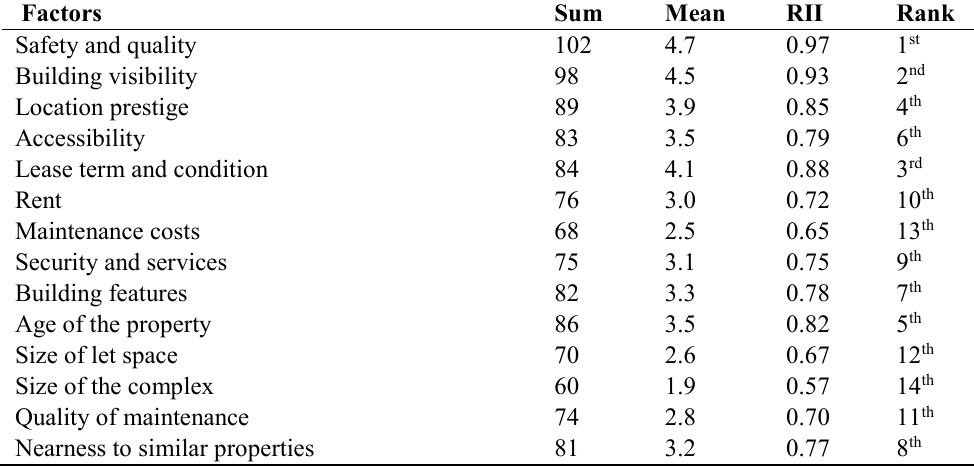
Table 6. Mean and Relative Importance Index (RII) of the Factors Perceived to Influence Rental Variation of Commercial Complexes in the Study